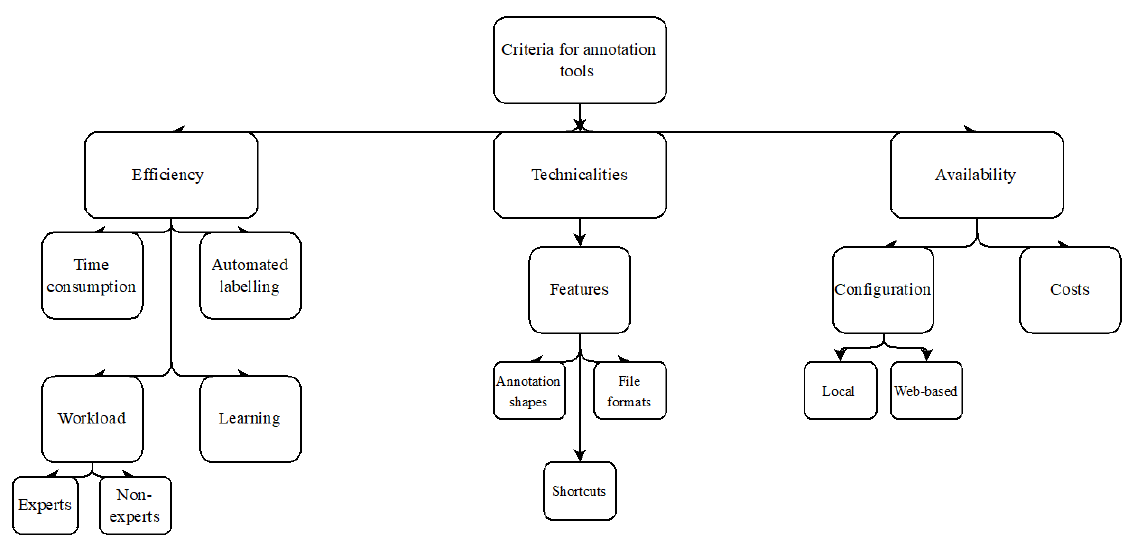
Figure 2. Flowchart of the criteria in question.